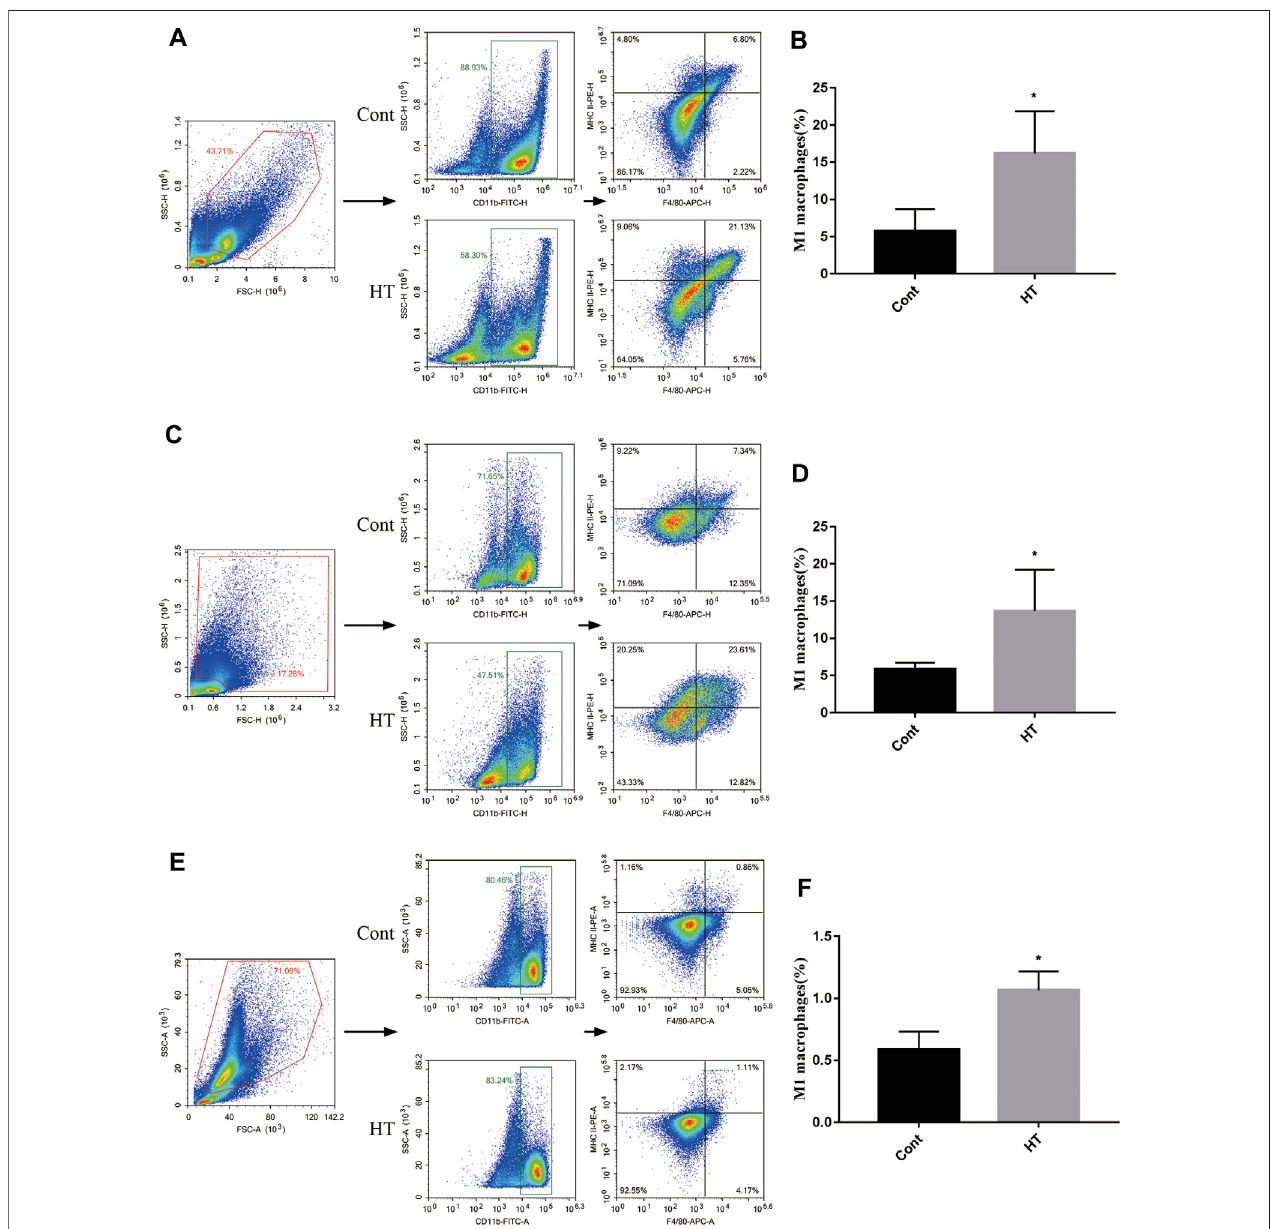
FIGURE 5 | HT promotes the proportion of M1 macrophages in the mice with orthotopic pancreatic tumor. The tumors, spleens and BM of mice in the control group andtheHTtreatmentgroupwereisolated.Theproportion ofM1macrophages(CD11b +F4/80+MHC Ⅱ +cells)inthetumors ( n (cid:2) 4ineachgroup) (A,B) ,spleens ( n (cid:2) 4 in each group) (C,D) and BM ( n (cid:2) 3 in each group) (E,F) was detected using fl ow cytometry (* p <